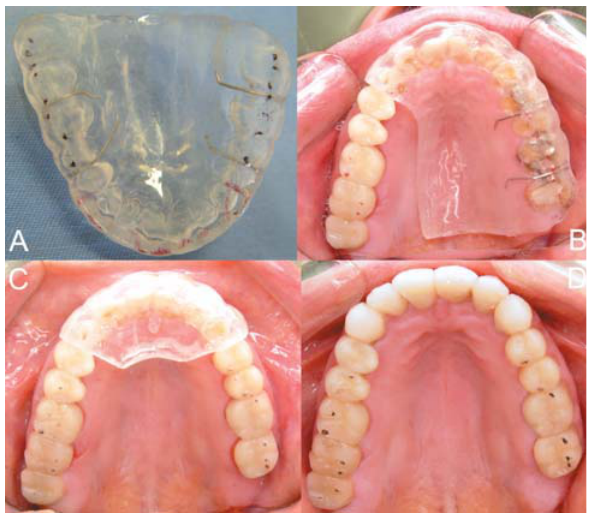
FIGURE 5- Occlusal splint during restorative procedures. A: occlusal adjustment with black spots denoting occlusal contacts and red spots denoting anterior guidances; B: restoration of posterior right teeth and occlusal adjustment of teeth/splint; C: restoration of all posterior teeth and occlusal adjustment of teeth/splint; D: restored teeth with